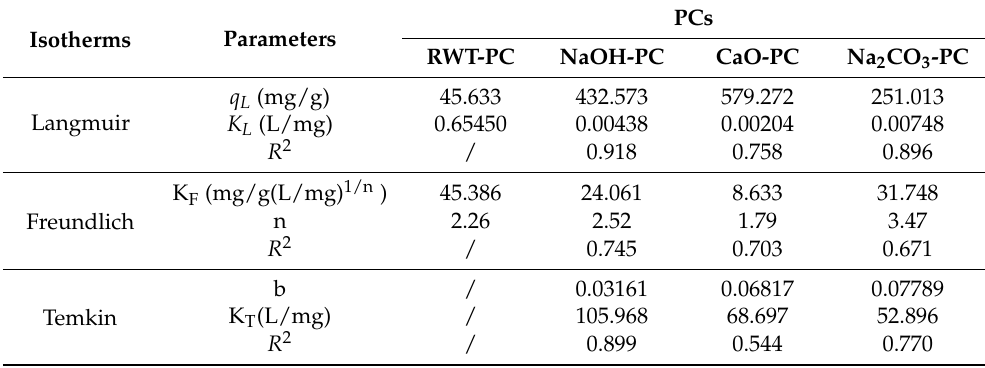
Table 5. Isothermal adsorption fitting parameters of MG on PCs.